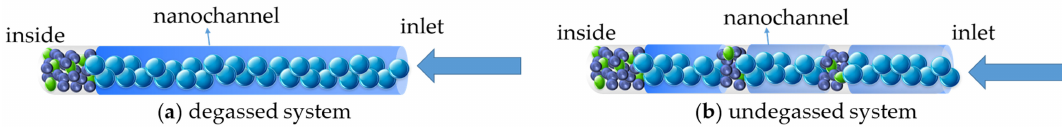
Figure 7. Cartoon of status of gas liquid in a nanochannel of degassed and undegassed systems. ( gas cluster, liquid